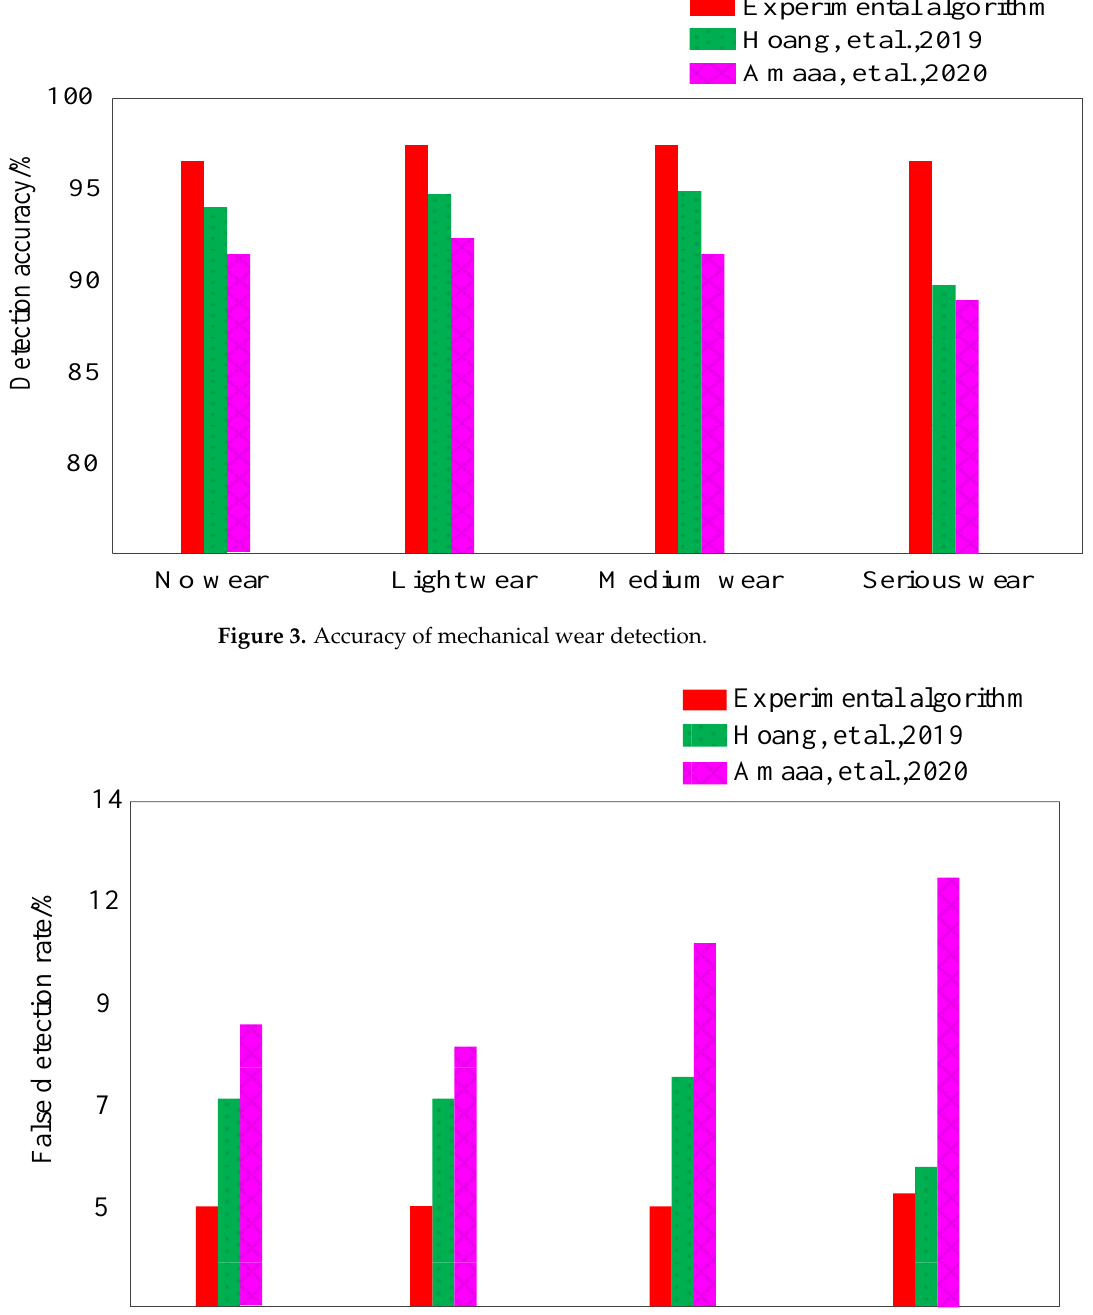
Figure 5. Missing rate of mechanical wear. It can be seen from the figure that the error detection rate and missed detection rate of mechanical wear detection based on the algorithm of Hoang. et al. [5] and Amaaa. et al. [6] were high, while the error detection rate and missed detection rate of mechanical wear detection using this experimental algorithm were low, and ideal mechanical wear detec- tion results could be obtained. This is because the experimental algorithm could better